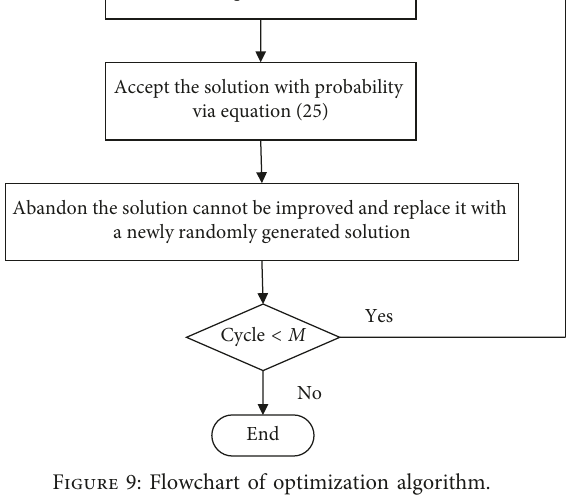
Figure 9: Flowchart of optimization